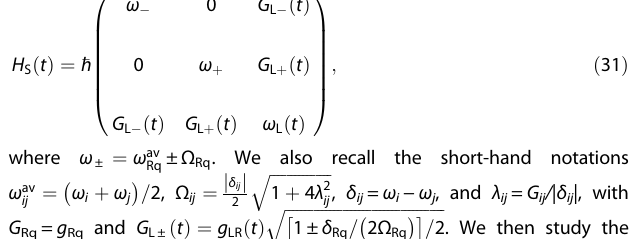
Fig. 6 Qubit initialization error as a function of the protocol duration. We present a comparison between different initial states and sweep times. For P 2 ð 0 Þ ¼ 1 , the initialization error is a strongly oscillating function of the protocol duration and its values are located within the shaded region. The physical parameters used are shown in Table 1. The decay time τ 10 = 300